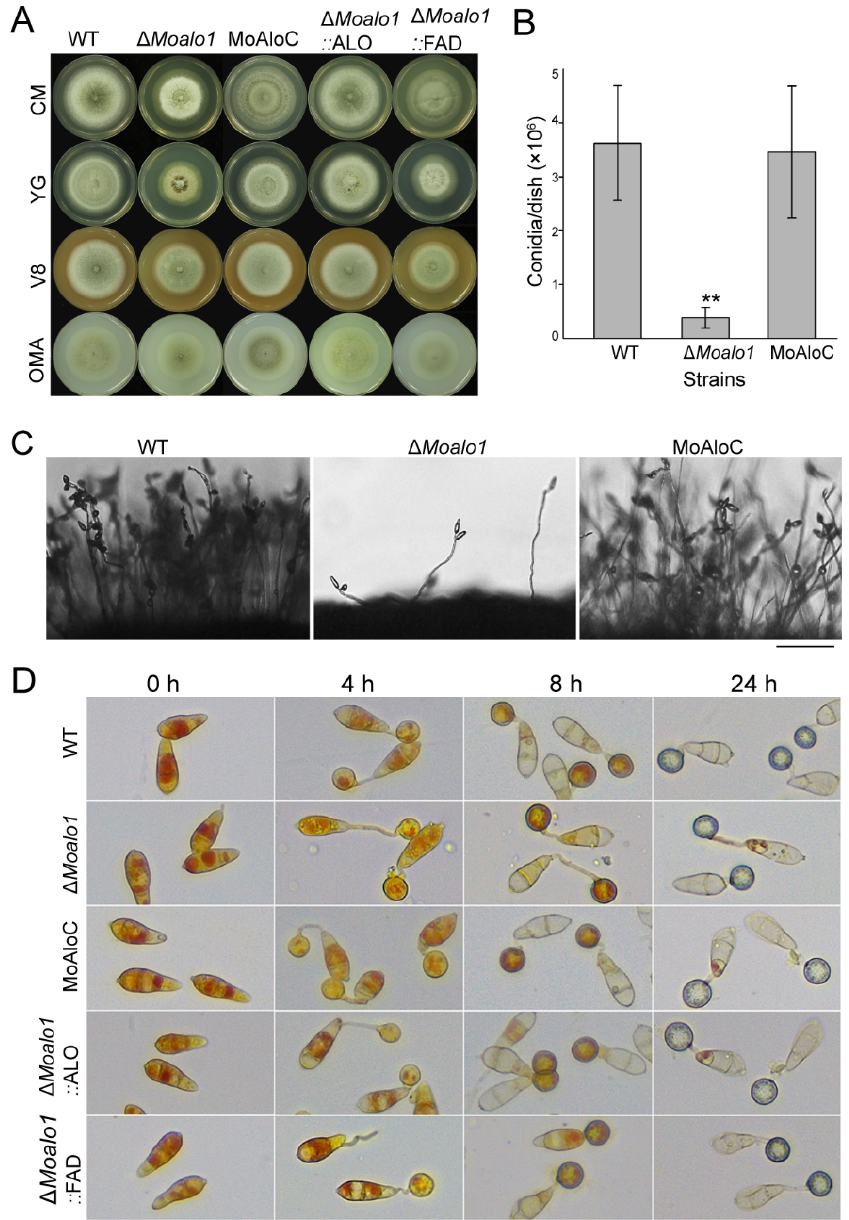
Figure 2. Deletion of MoALO1 influences mycelial growth and conidiogenesis of M . oryzae . ( A ) Colony morphology of Guy11, ∆ Moalo1 , the complementary strain MoAlo1C, ∆ Moalo1 ::ALO, and ∆ Moalo1 ::FDA. Strains were cultured on CM, YG, V8, and OMA plates at 25 ◦ C for 8 days before photography. ( B ) The number of conidia produced by Guy11 and ∆ Moalo1 . Prism 7.0 software was used to analyze the data. Asterisks indicate statistically significant differences ( t test, ** p < 0.01). ( C ) Microscopic observation of asexual development. Conidiophores and conidia were observed after 24 h of constant light induction. Bar = 100 µ m. ( D ) Glycogen distribution of the conidia and appressoria of strains. Glycogen was stained with KI/I 2 solution and appears as dark brown deposits in conidia and appressoria. Bar = 30 µ